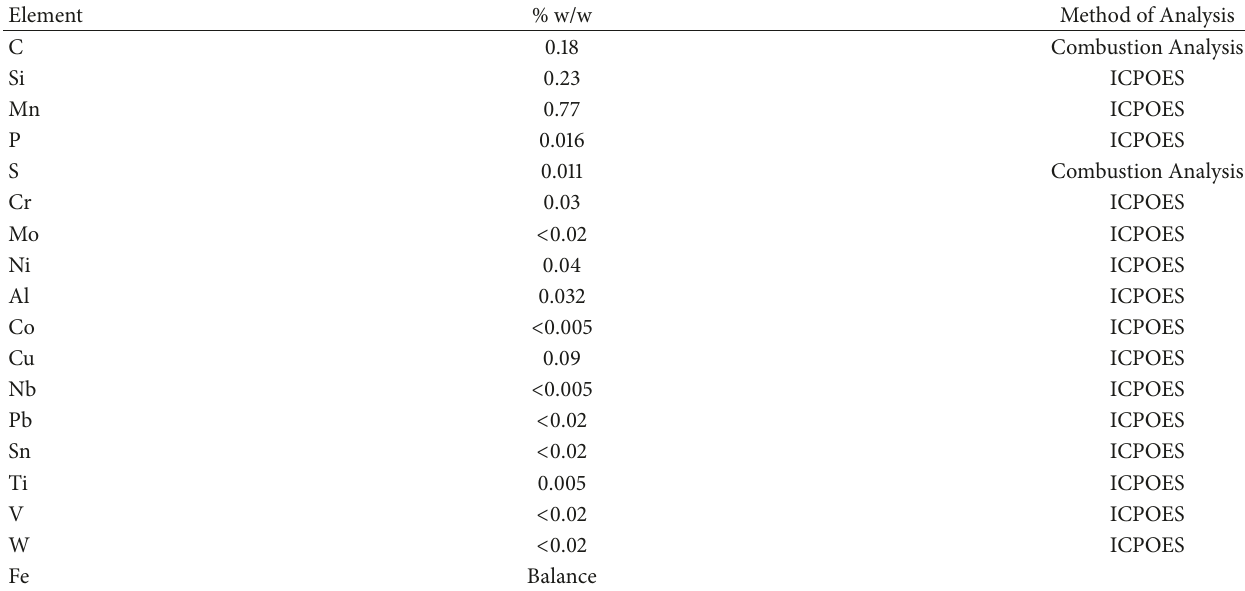
Table 1: Chemical composition of mild steel.